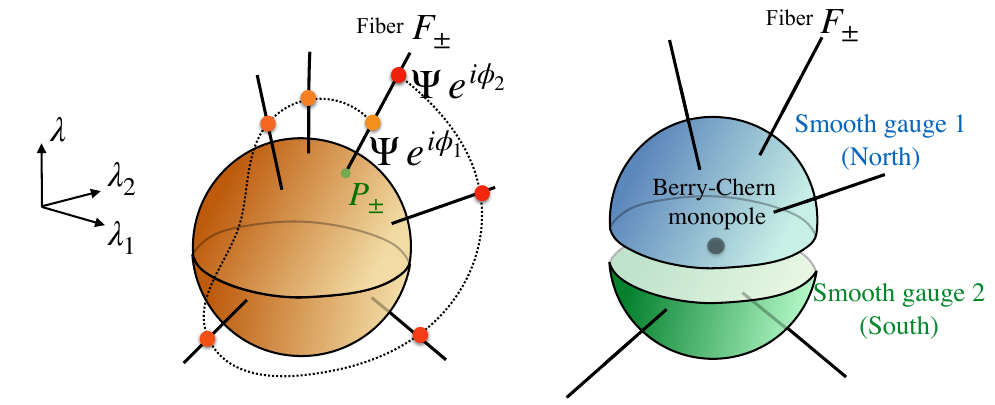
Figure 2: (a) U ( 1 ) fiber-bundle as a continuous collection of fibers F over the sphere defined in parameter space λ . Two states in the same fiber only differ by a phase; they thus have the same projector onto the base space. The impossibility to define smoothly this phase over the base space is a manifestation of the topological property of the fiber bundle, encoded into the Chern number. (b) This Chern number is the quantized flux through the sphere of the Berry curvature generated by the degeneracy point, called Berry monopole. The existence of a non-zero Chern number imposes the 1-form Berry connection to be defined smoothly only